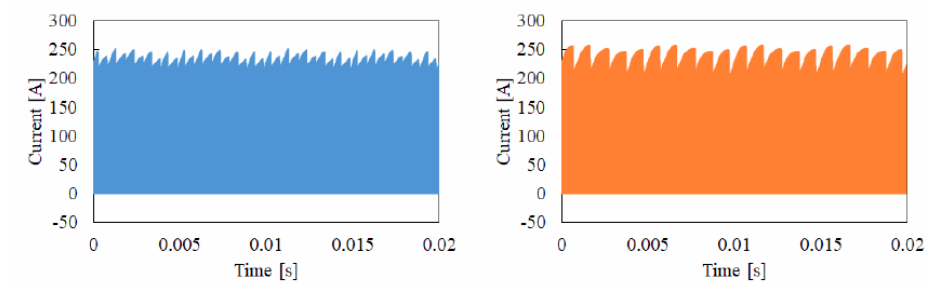
Figure 16. DC current ripple. ( Left ) shows the ripple without phase shift control and ( right ) shows it with phase shift control.